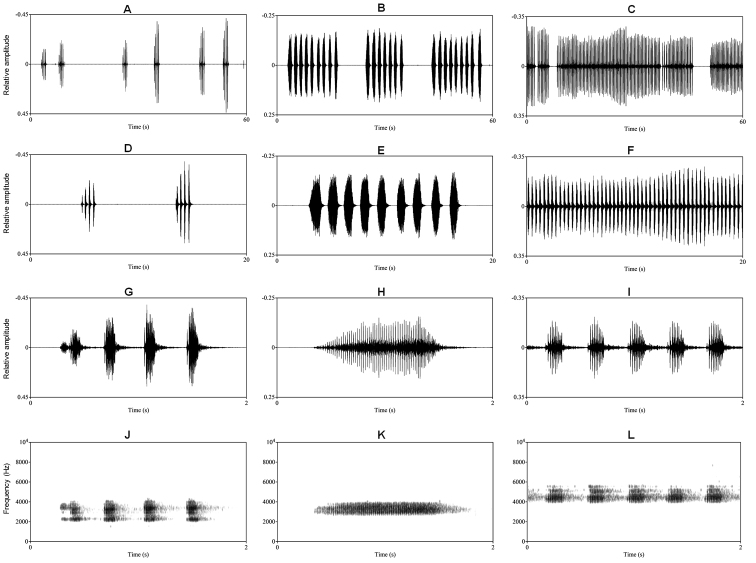
Visualization of advertisement calls of three Megophrys species from Medog. A–C visualizations of 60 seconds waveform of relative amplitude over time for M.
medogensis (one unvouchered individual recorded in the vicinity of Medog urban area), M.
cf.
pachyproctus (CIB022017061807), and Megophrys
yeae sp. nov. (paratype CIB022017061804), respectively D–F visualizations of 20 seconds waveform of relative amplitude over time G–I visualizations of two seconds waveform of relative amplitude for the species, respectively J–L visualizations of two seconds waveform of spectrogram for the species, respectively.